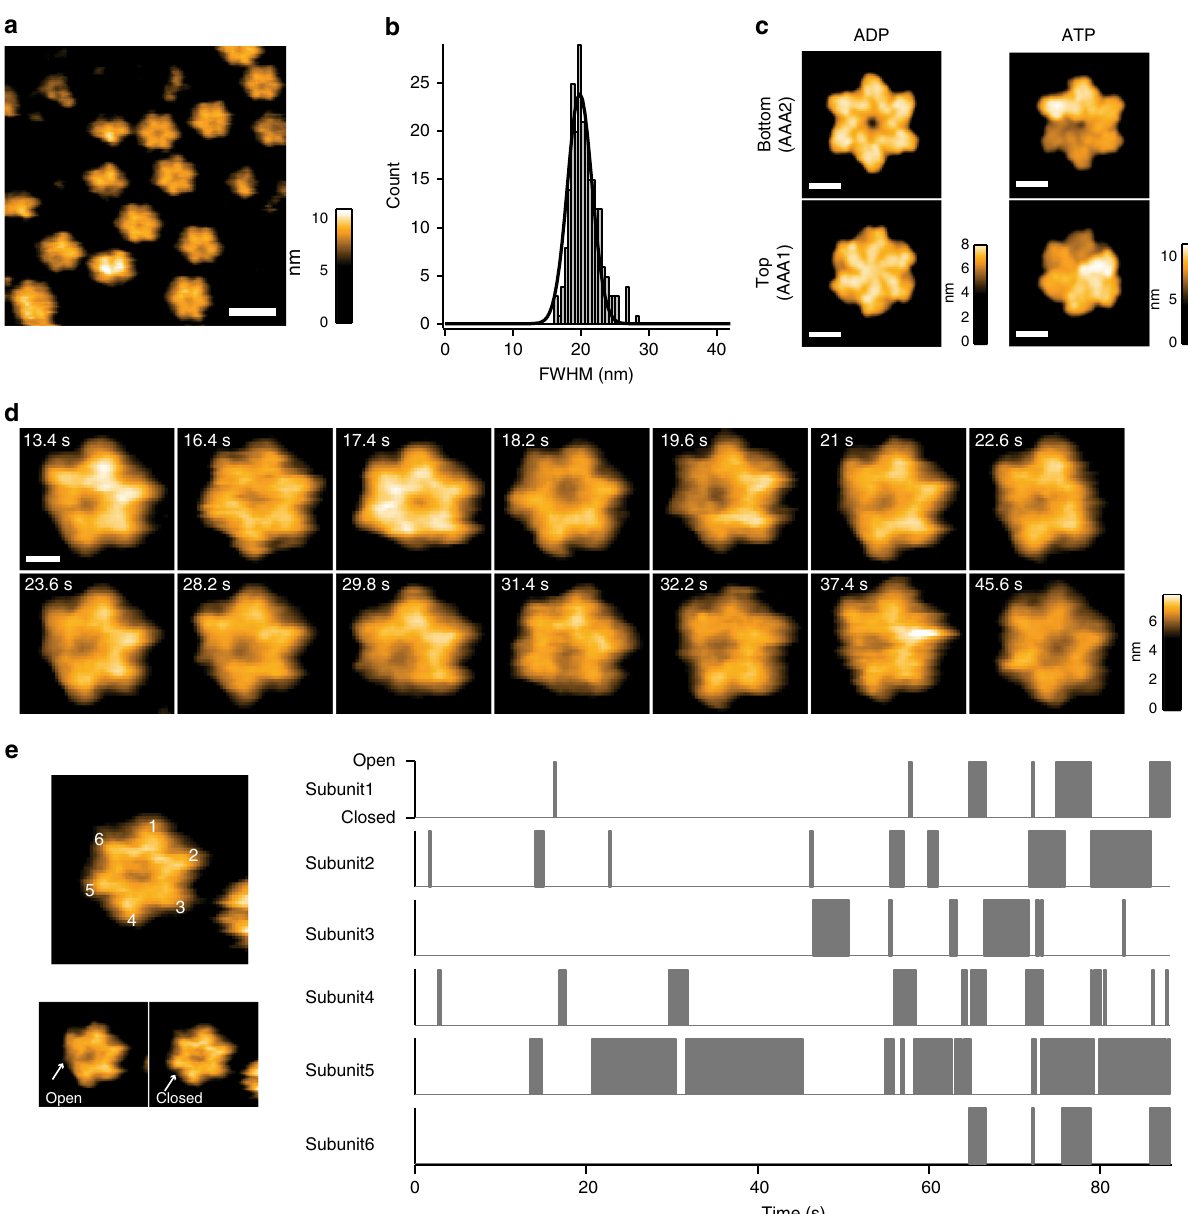
Fig. 6 Observation of real-time Abo1 conformational change by HS-AFM shows stochastic AAA + ring symmetry breaking. a Representative high-speed AFM image of Abo1 hexamer immobilized on an APTES-treated mica surface in the absence of nucleotide. Scale bar = 20 nm. b Full width at half-maximum (FWHM) histogram of Abo1 molecules fi t to a Gaussian distribution with a mean ± SD of 19.8 ± 2.6 nm. c AFM data simulations of Abo1 in different nucleotide states using models from cryo-EM data. Top panels show “ bottom view ” from the AAA2 domain side, and bottom panels show “ top view ” from the AAA1 domain side. Scale bar = 5 nm. d Snapshots of an Abo1 molecule undergoing conformational change upon ATP addition. Movies were taken at a frame rate of 5 Hz. Scale bar = 5 nm. e Analysis of the position of Abo1 ring opening (gray boxes) sorted by subunit according to time shows random subunit activation. Additional examples shown in Supplementary Fig.